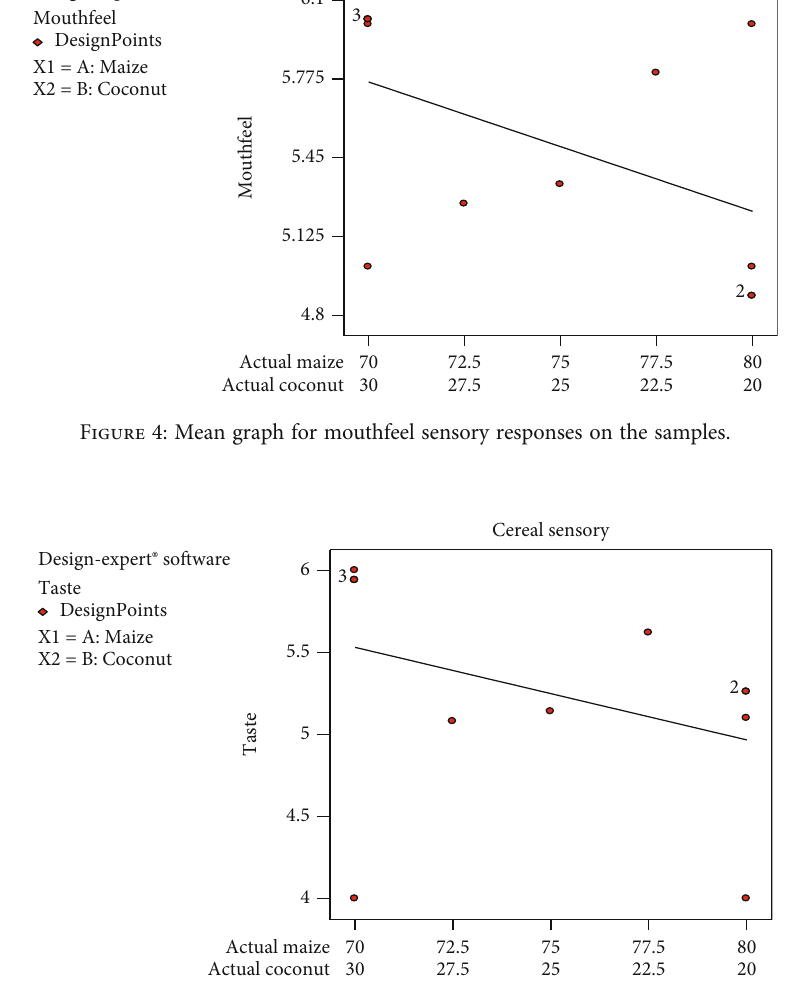
Figure 5: Mixture mean graph for taste sensory responses on the